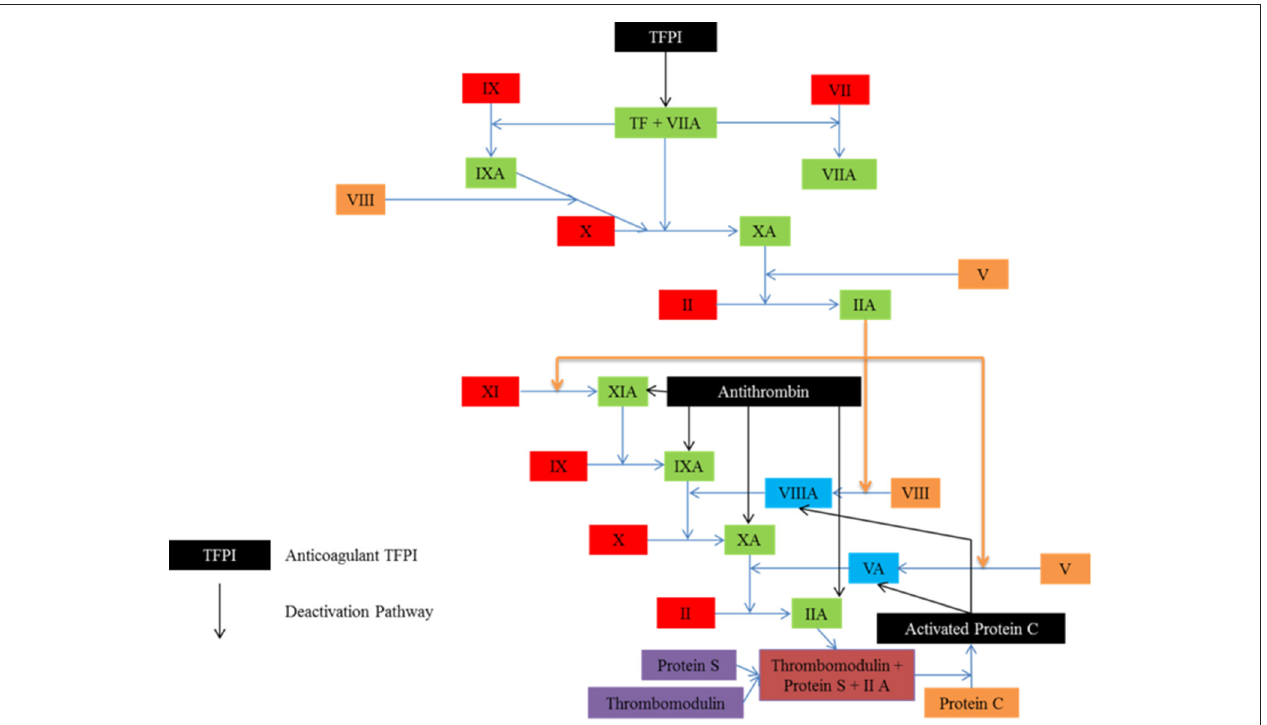
FIGURE 3 | Several anticoagulant mechanisms exist to ensure that clotting is limited to where it is needed. Tissue factor pathway inhibitor (TEFI) inhibits tissue factor, the protein responsible for clot initiation. Antithrombin targets the activated factors, while activated protein C inhibits the activated